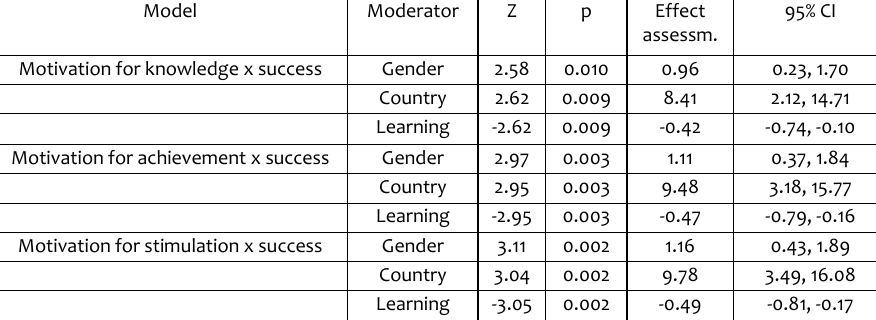
Table 6. Moderation